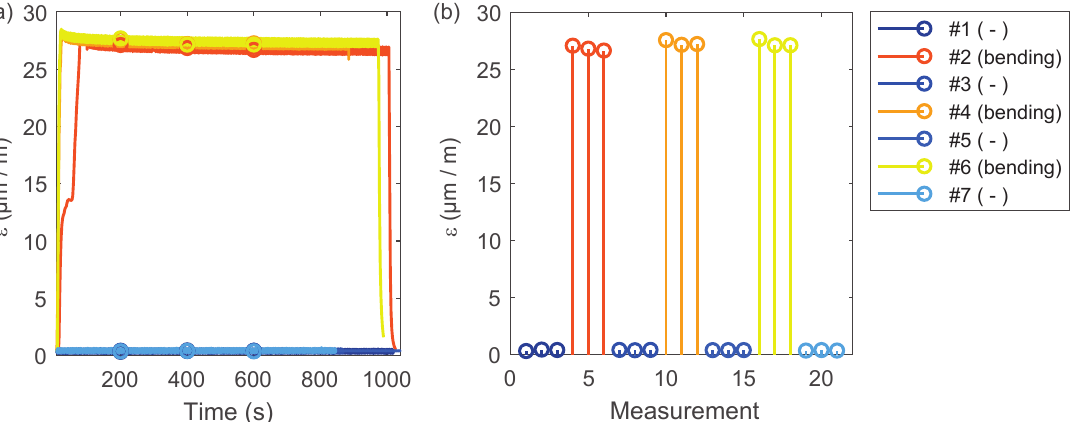
Figure 6. ( a ) Static strain that is proportional to the current bending loads as a function of time. ( b ) Modified representation of (a) showing the alternating nature of the applied loading. Three EMI measurements were successively recorded during one loading